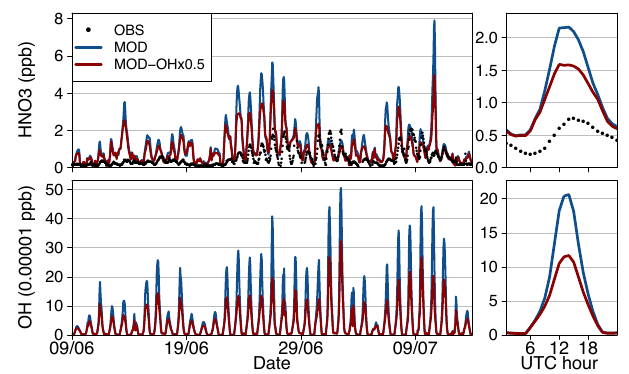
Figure 10. HNO 3 and OH hourly concentrations (left panel) and diurnal profiles (right panel) at the LHVP